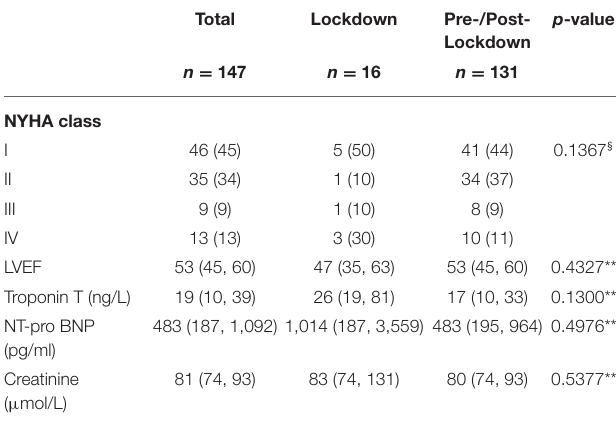
TABLE 4 | Identification of predictors of intentionally delayed presentation.